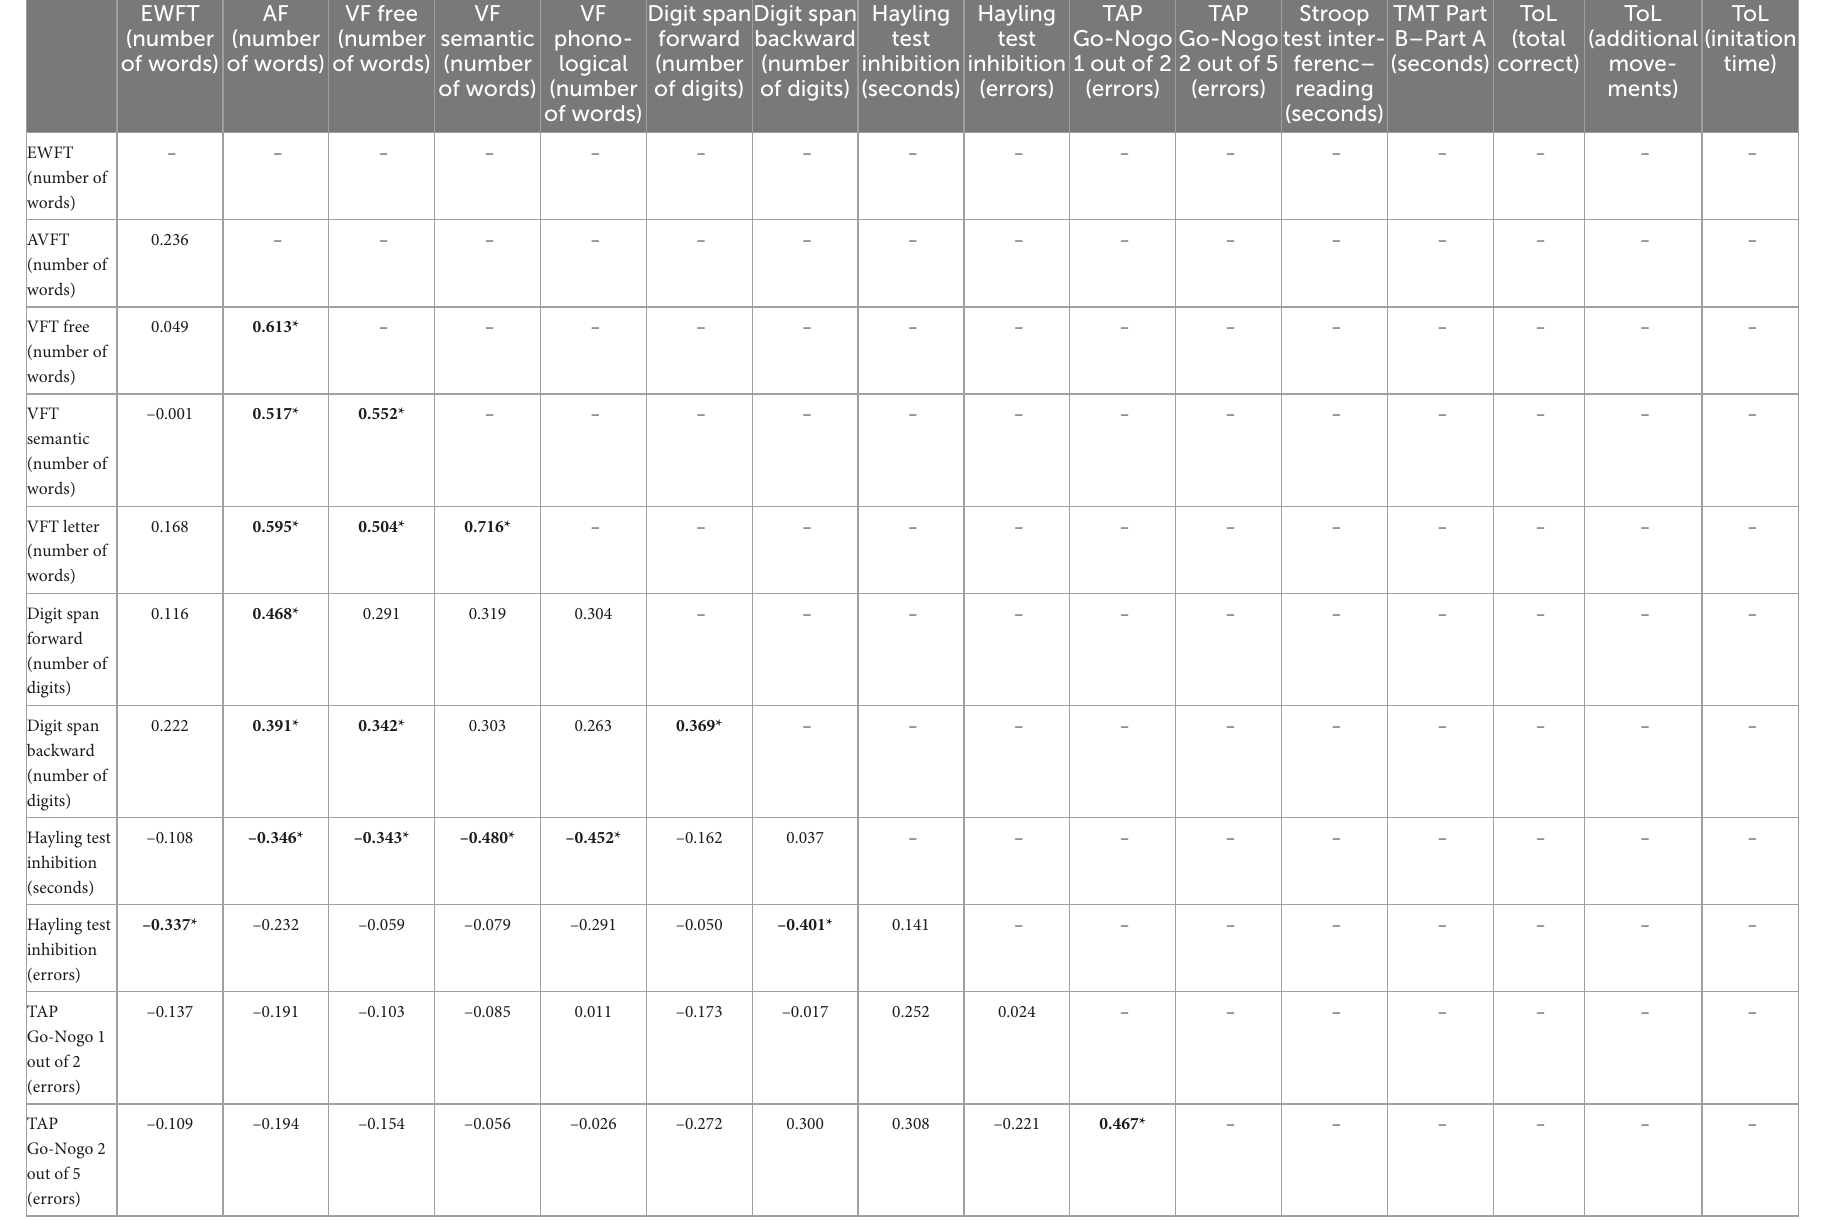
TABLE 6 Pearsons’s correlation matrix for performance on executive tests, number of emotions and actions in attention deficit hyperactivity disorder (ADHD) group ( n =